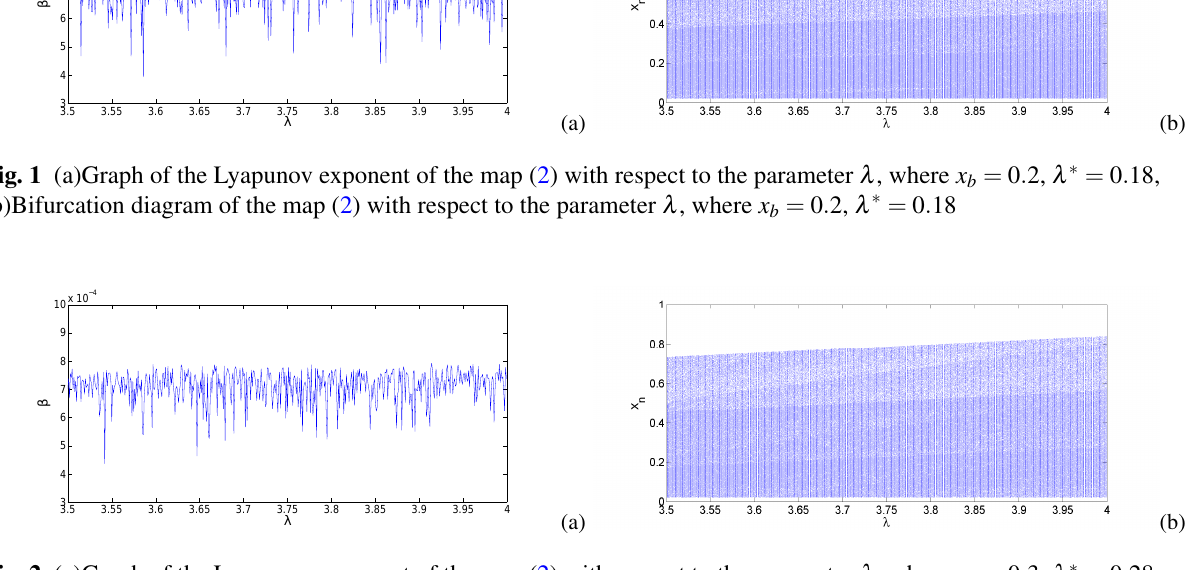
Fig. 2 (a)Graph of the Lyapunov exponent of the map (2) with respect to the parameter λ , where x b = 0 . 3, λ ∗ = 0 . 28, (b)Bifurcation diagram of the map (2) with respect to the parameter λ , where x b = 0 . 3, λ ∗ = 0 .